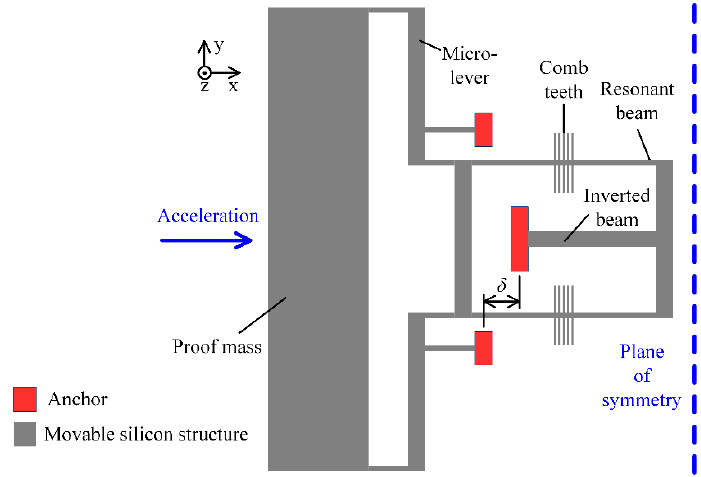
Figure 1. A schematic of the sensing structure (half of the symmetric device).